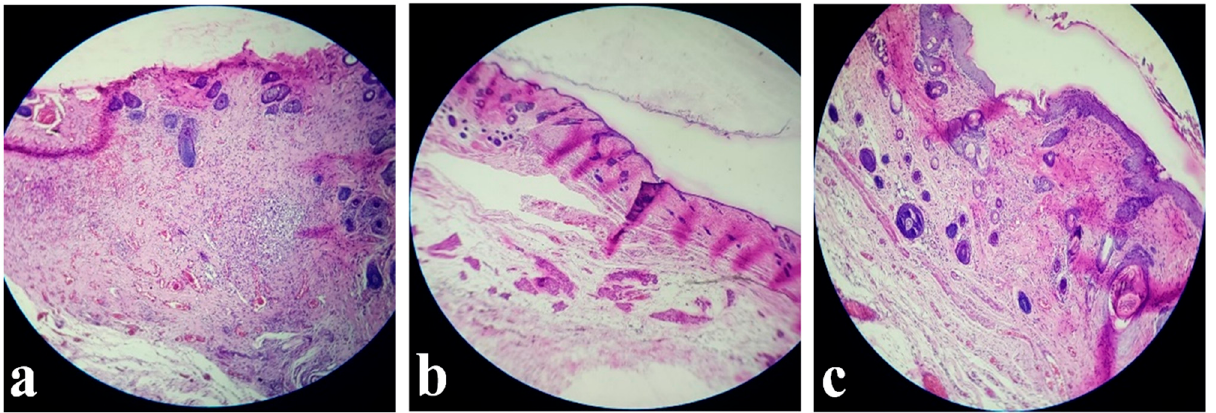
Figure 3. Histological images illustrating: ( a ) Island margins/edges with inflammatory infiltrate; ( b ) middle of the island without histopathological changes; ( c ) minimal inflammatory infiltrate in dermis and vascular congestion (10×).